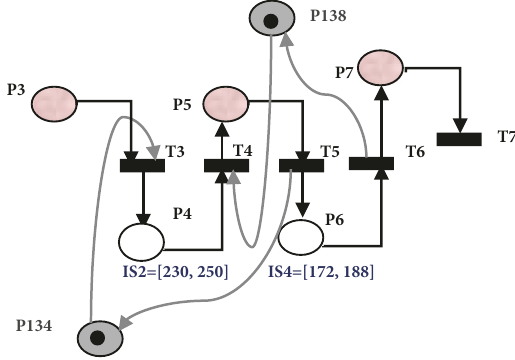
Figure 6: Catch-up places P133 and P137 [13].